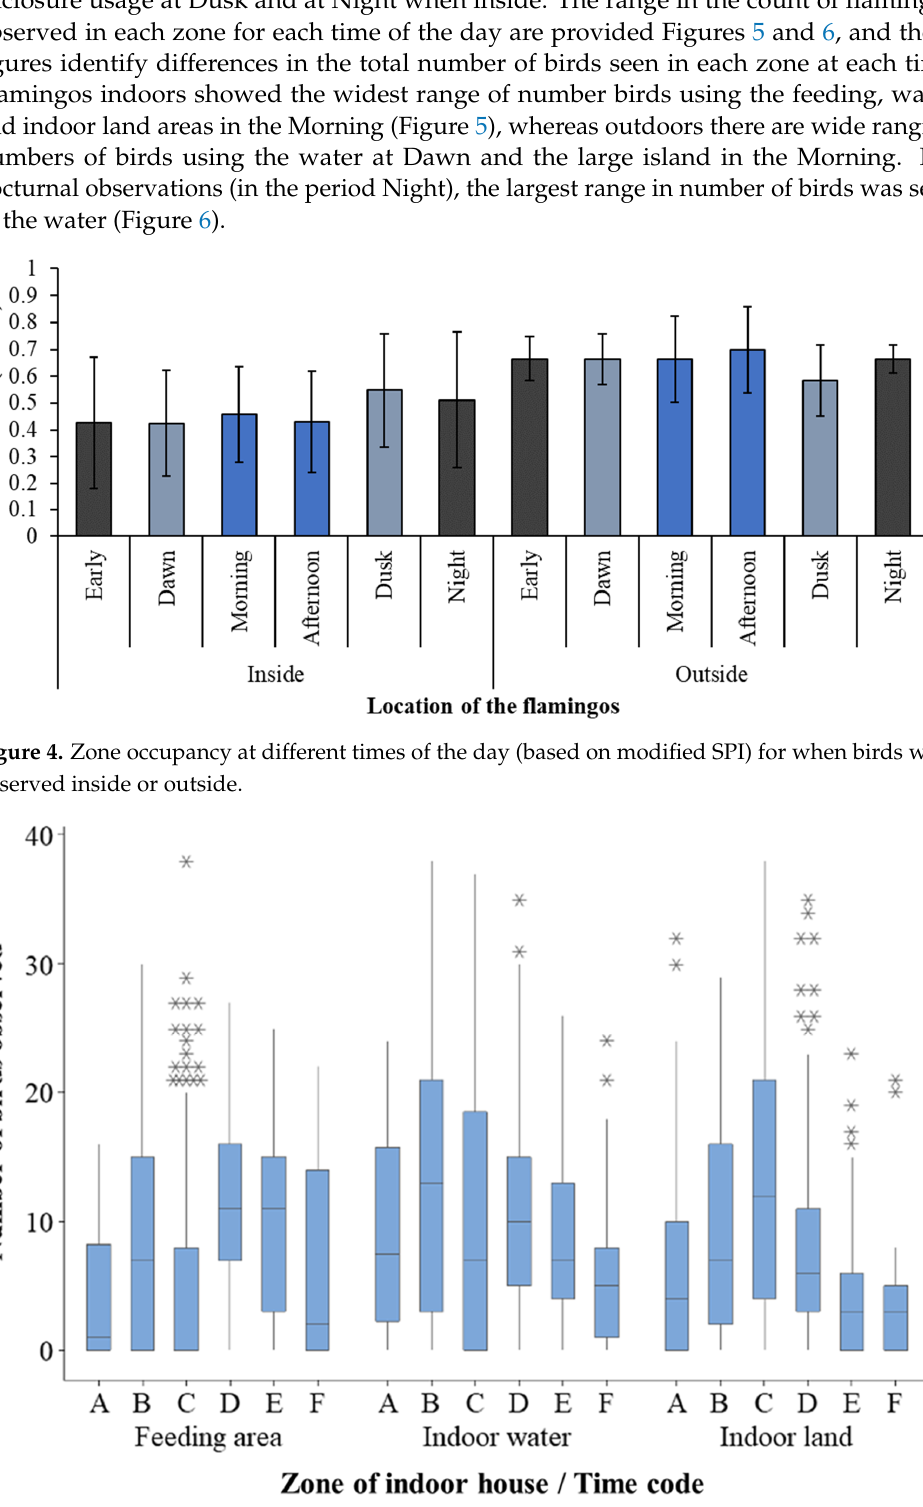
Figure 5. Count of birds in different indoor zones by time of day. A = Early; B = Dawn; C = Morning; D = Afternoon; E = Dusk; F = Night. * show outliers.